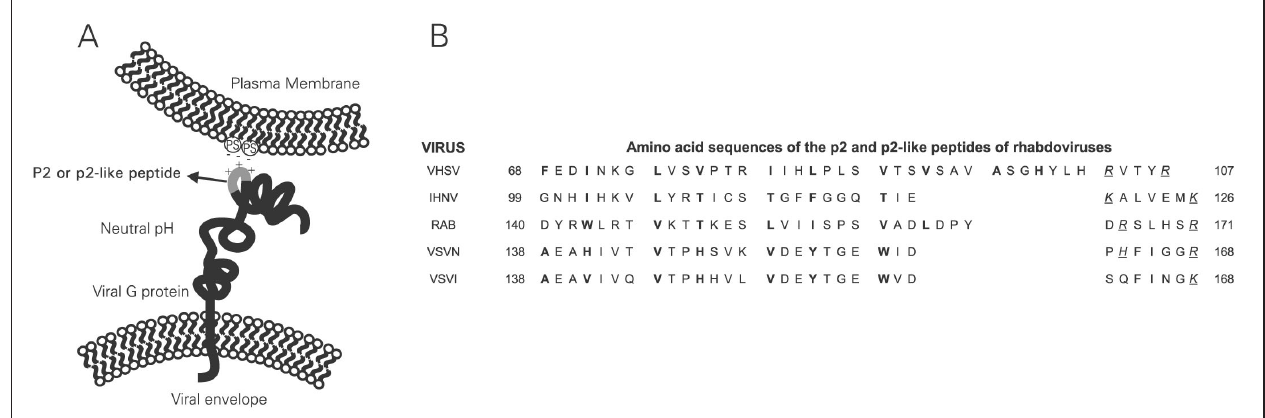
Figure 2. Binding of the G protein of rhabdoviruses to the cell surface. A , Schematic representation of the interaction between viral G protein and phosphatidylserine (PS) in the plasma membrane, at neutral pH, showing the importance of electrostatic interactions for the binding. A specific sequence of G protein directly involved in the binding to the negatively charged phospholipid PS is shown in gray. This sequence presents similar structural features in the G protein of all rhabdoviruses and is named p2 or p2-like peptide (20). B , PS-binding segments of rhabdovirus G protein contain heptad repeats followed by a short segment containing at least one positively charged residue (20). The heptads are separated by a space for better visualization. The numbers shown on the left or right correspond to the first and the last amino acid residue in each sequence, respectively. VHSV = viral hemorrhagic septicemia virus; IHNV = infectious hematopoietic necrosis virus RB-1 strain; RAB = rabies B19 strain; VSVN = vesicular stomatitis virus New Jersey strain; VSVI = vesicular stomatitis virus Indiana